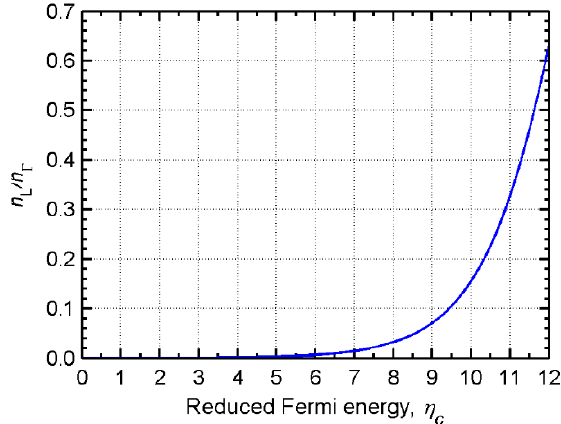
Figure 7. Calculated electron concentration ratio of n L to n Г as a function of the reduced FE for GaAs in thermal equilibrium ( T L = 300 K).